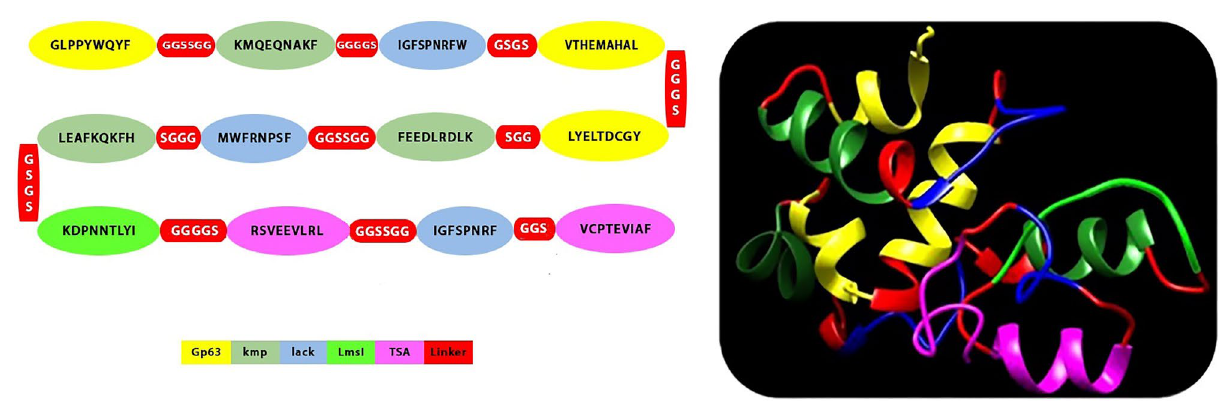
Figure 1. The final epitopes for DNA vaccine designed by several servers and use of linkers between